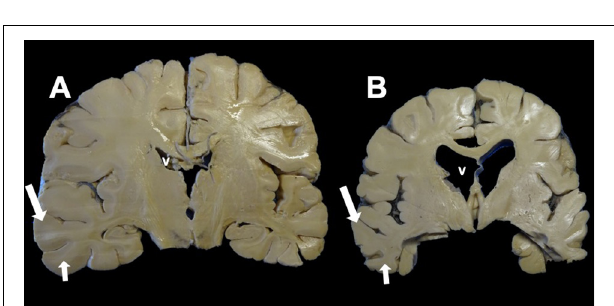
FIGURE 3 | Coronal section of the brain. (A) Control. (B) Alzheimer’s disease (AD). Macroscopic morphological changes are observed. In AD, there is a reduction in the size of the brain associated with neuronal death caused by neurofibrillary tangles (NFTs). The ventricles ( v ) and the grooves between the convolutions widen, and there is a considerable reduction in the thickness of the gray matter ( large arrow ) and white matter ( small arrow